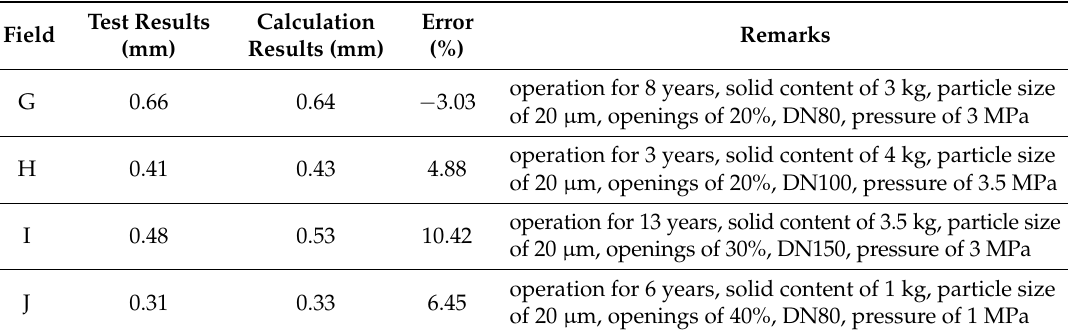
Table 5. Verification results of the maximum erosion rate with field test data in Sichuan